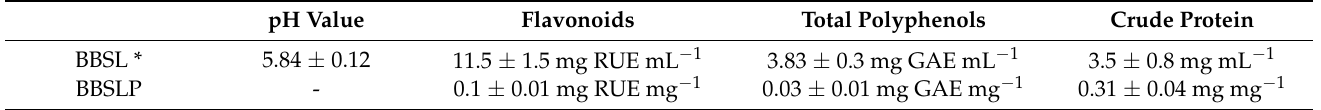
Table 1. pH, Flavonoids, total polyphenols and crude protein levels of BBSL and